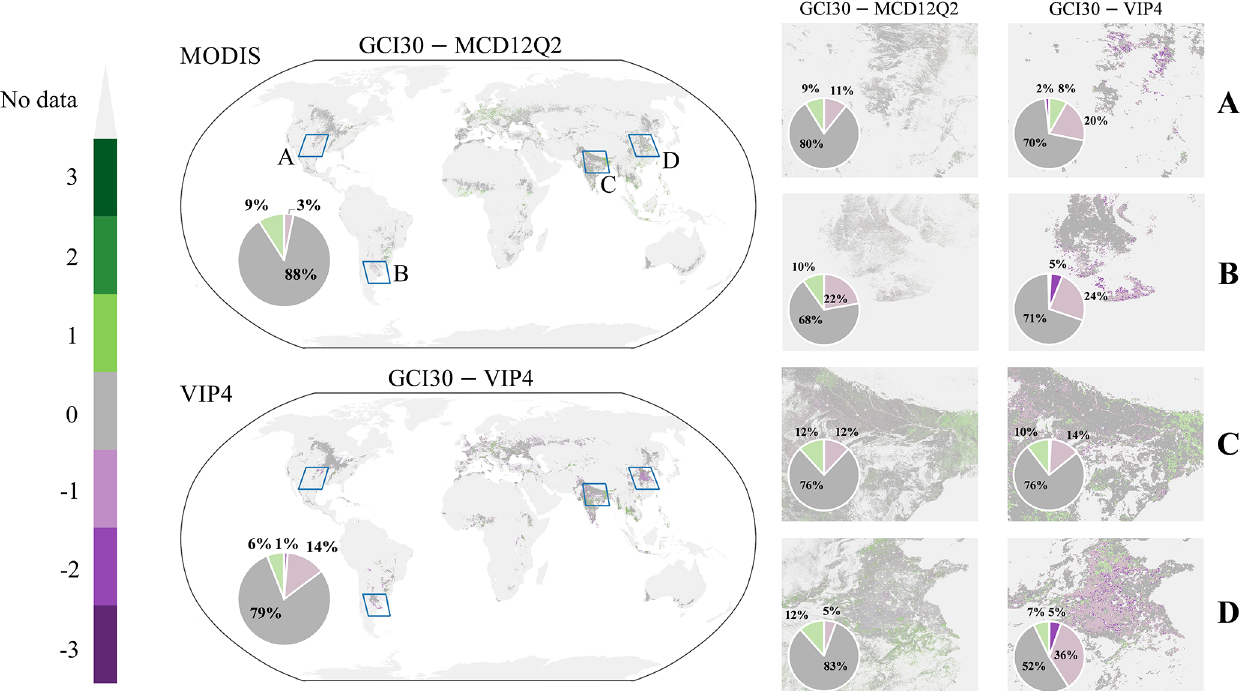
Figure 10. Spatial patterns and statistics of the CI differences among GCI30, MCD12Q2, and